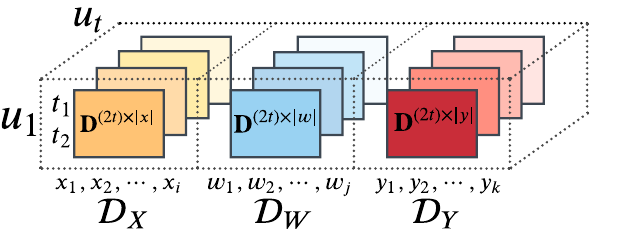
Figure 2. Graphic visualization sample of the 4d tensor resulting from the data processing. The figure has been created using Lucidchart. Url: https:// www. lucid chart.